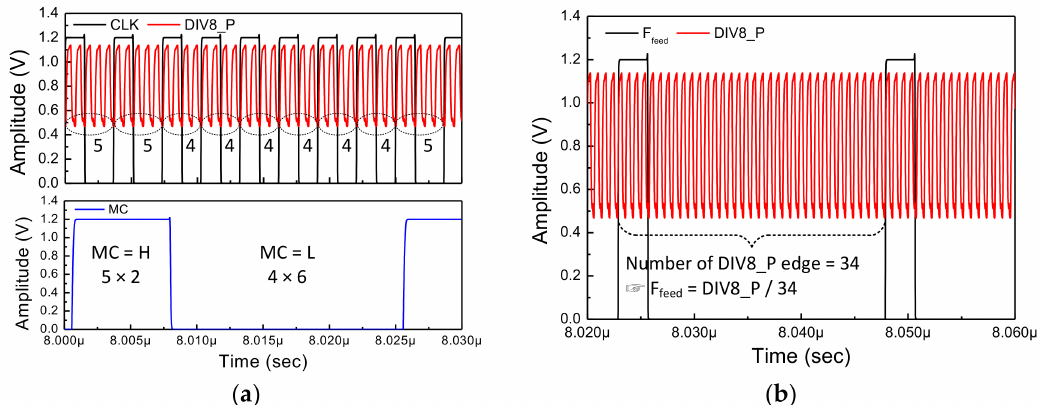
Figure 15. The simulation results of the pulse swallow counter in time domain. ( a ) The relationship between the Div8_P (Div8_N) signals and the CLK can be checked together with respect to changing in the MC value; ( b ) Relationship between the input and output of the pulse swallow